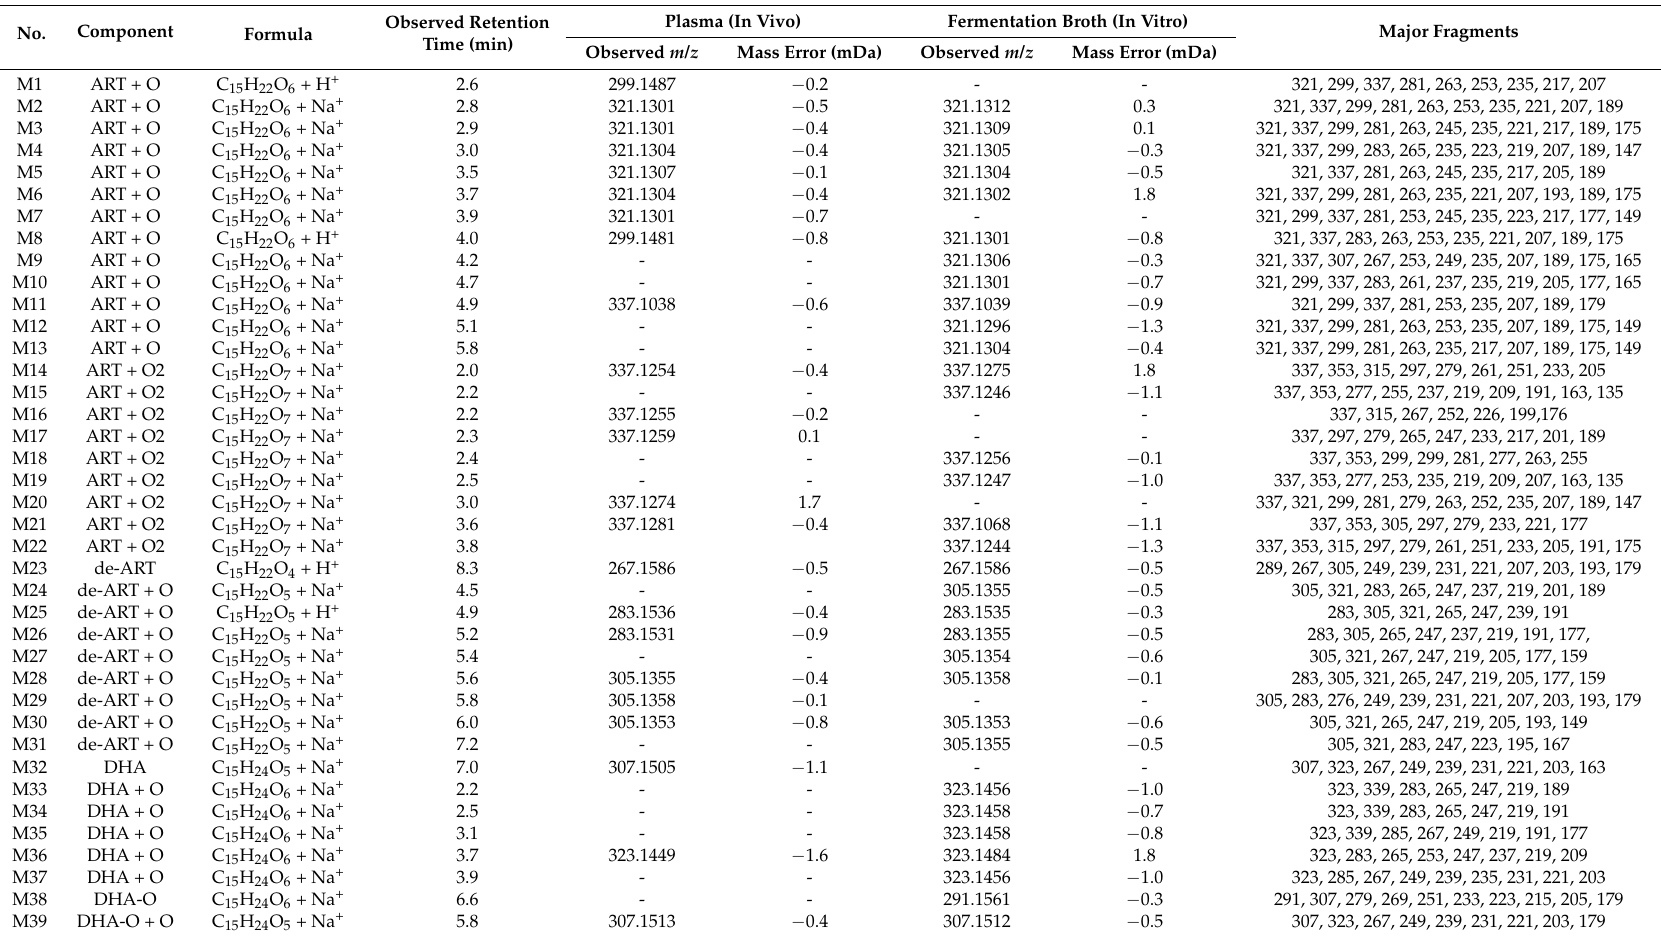
Table 1. Summary of metabolites of ART detected in mouse plasma (in vivo) and microbial transformation system (in